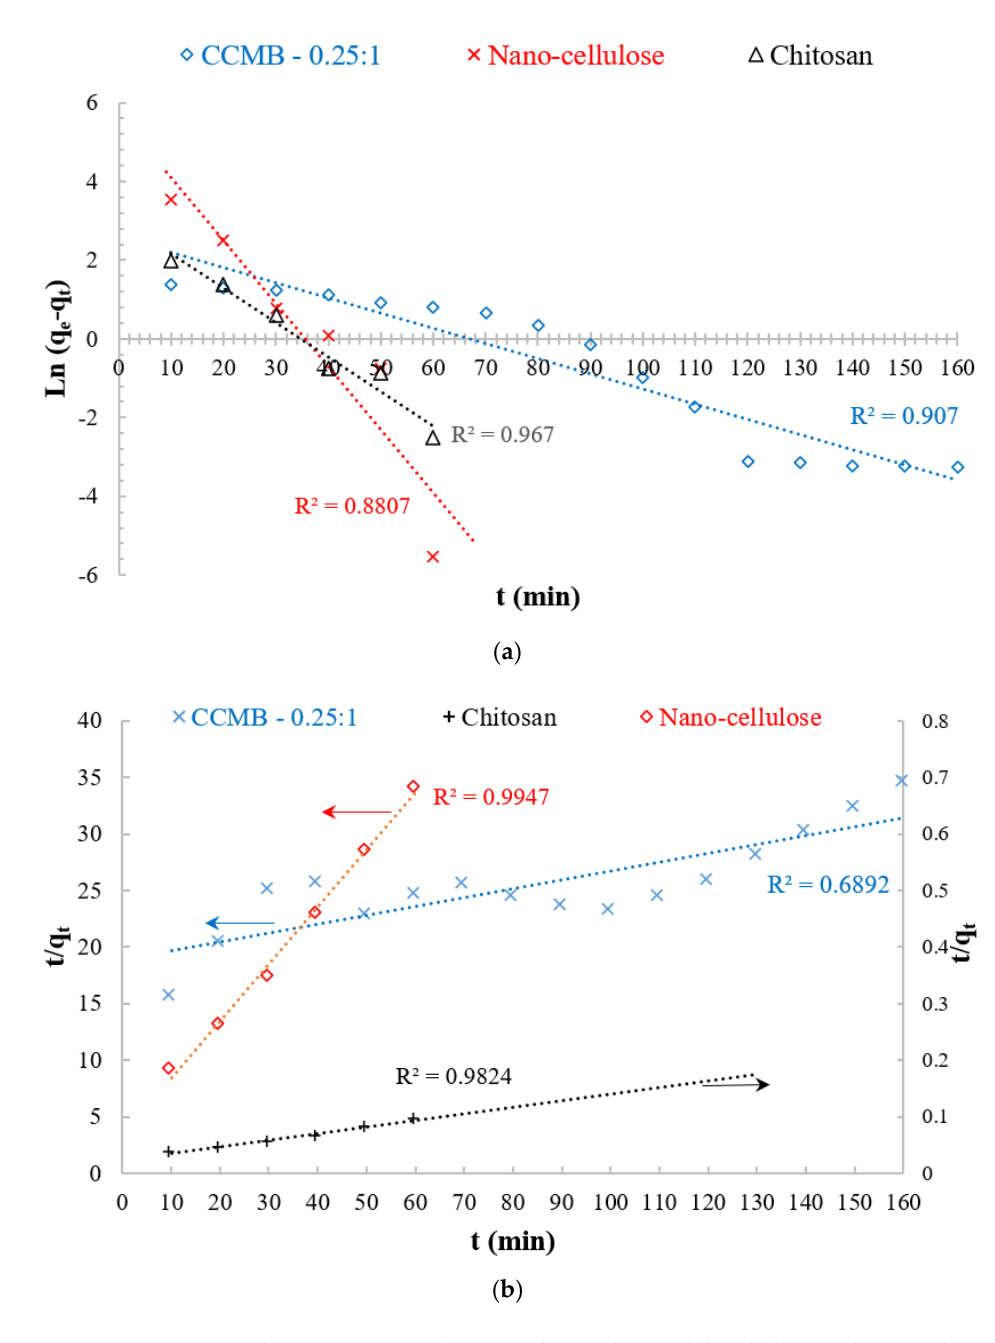
Figure 22. Adsorption kinetic studies: ( a ) pseudo first-order model and ( b ) pseudo second-order model.